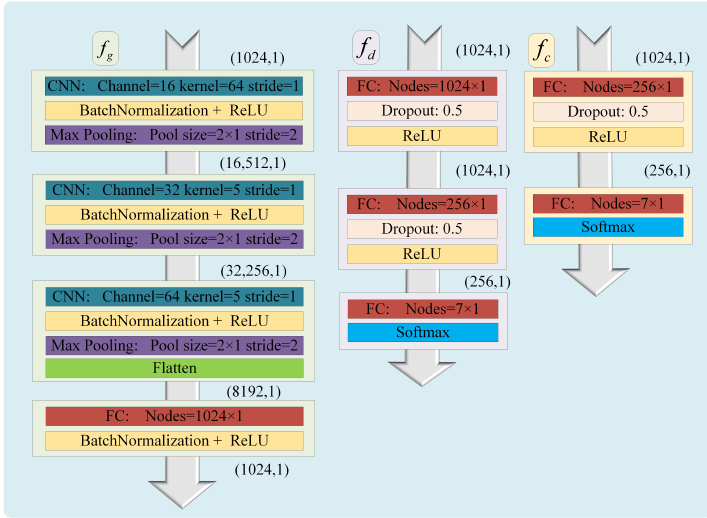
Figure 4. The designed architecture and key